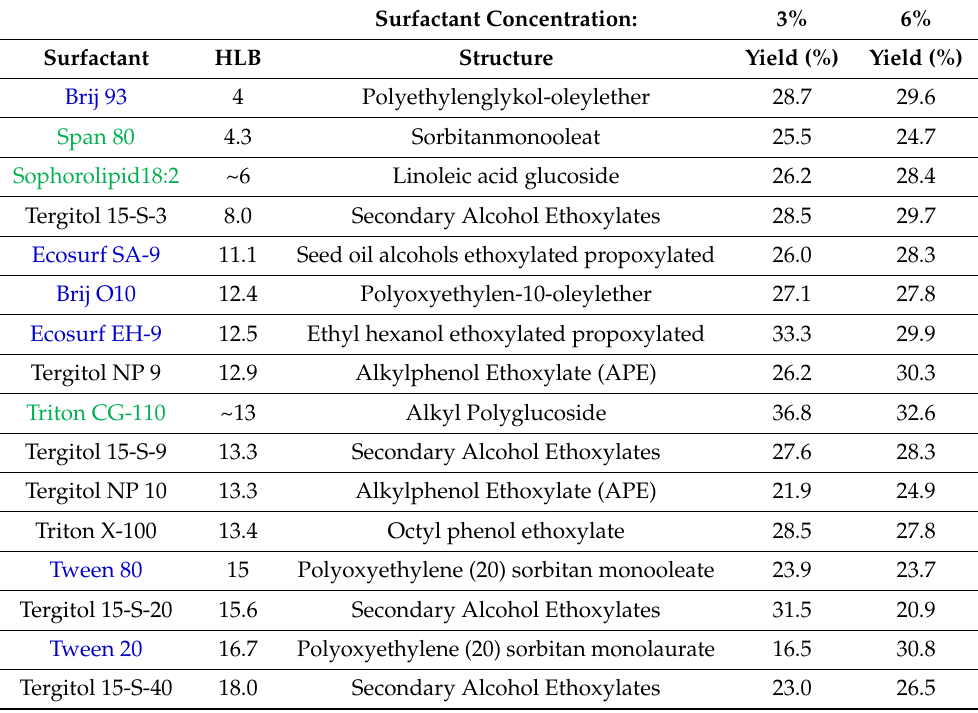
Table 1. List of surfactants in order of their HLB value, black = non-biobased, blue = partially biobased and green = fully biobased surfactants; yield of HPODE in the presence of detergents (% relative to substrate volume) after 2 h of reaction time with 20,000 U LOX-1/mmol linoleic acid. Reference without detergent had a yield of